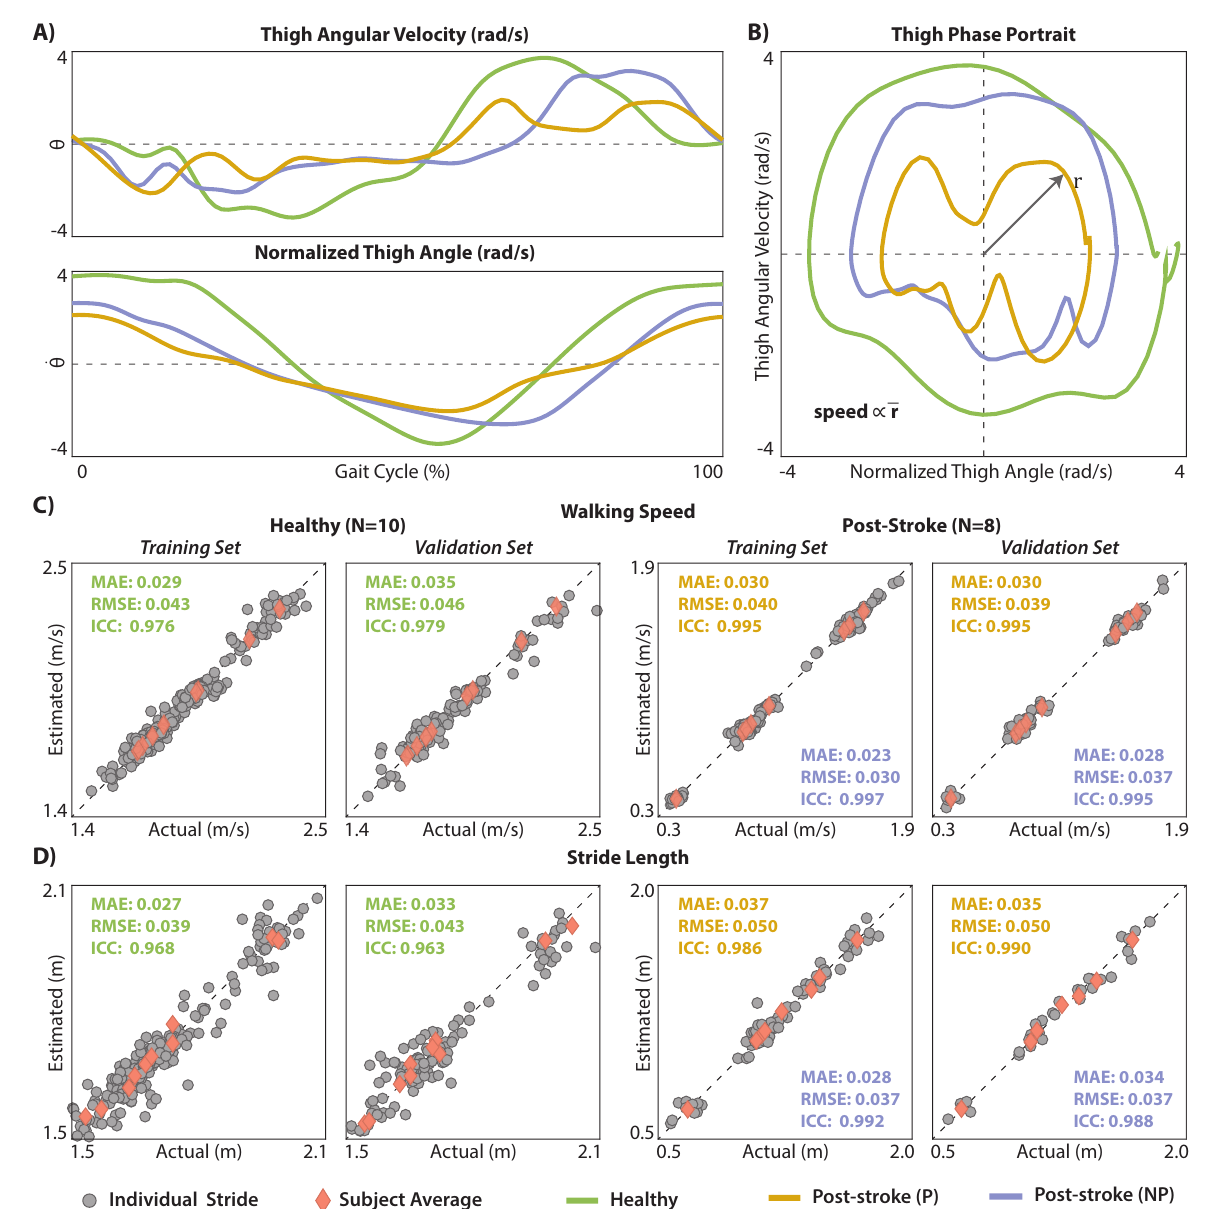
Figure 2. Thigh phase portrait and walking speed and stride length estimation accuracy: ( A ) Angular position and velocity measured by a thigh IMU (after filtering and normalization of the thigh angle) for one healthy study participant and the paretic and nonparetic limbs of a person post-stroke. ( B ) Exemplar phase portraits generated using data plotted in ( A ). ( C ) Accuracy of walking speed estimation within and across subjects. ( D ) Accuracy of stride length estimation within and across